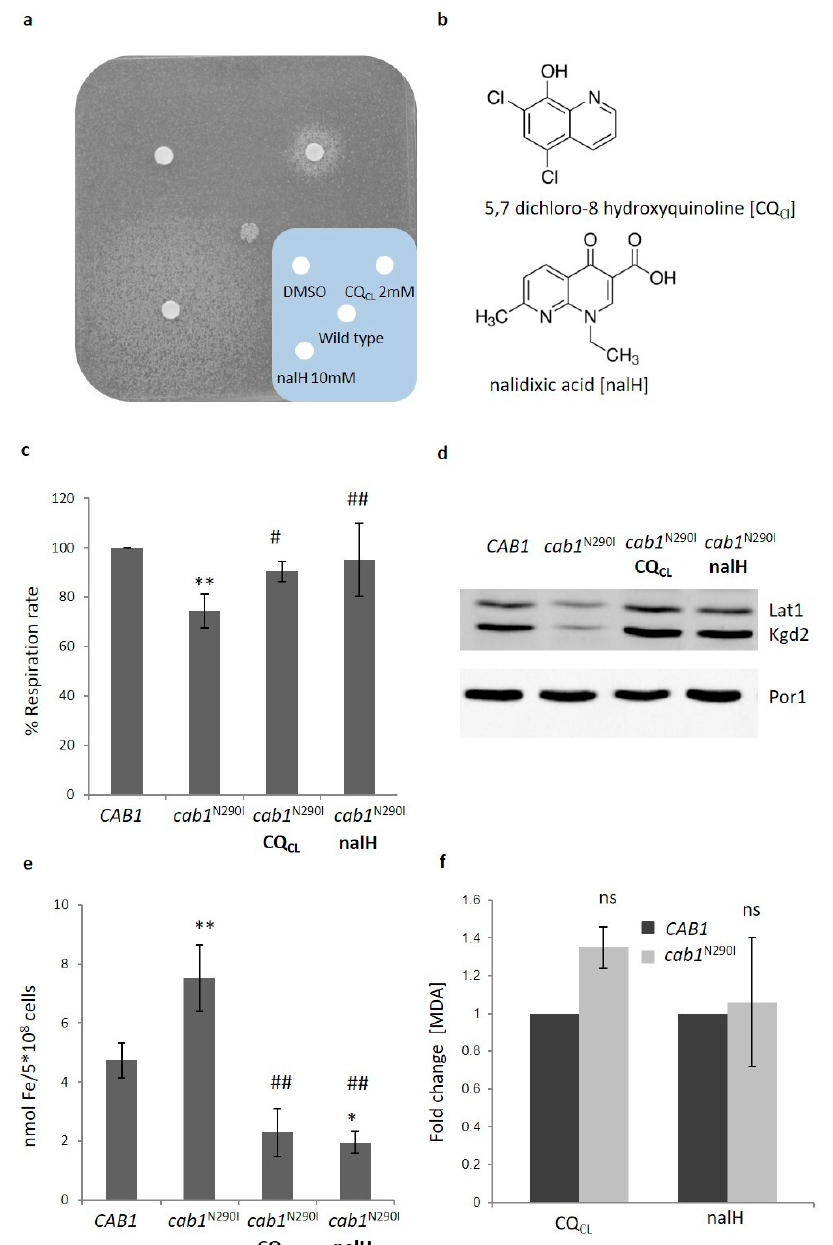
Figure 6. ( a ) 4 × 10 5 ( cab1 N290I ) cells were plated on YP medium supplemented with 2% ethanol. Three sterile filters were soaked with 2.5 µ l of each compound or DMSO. Plates were incubated at 28 ◦ C for 5 days. ( b ) Chemical structure of 5,7 dichloro-8 hydroxyquinoline (CQ CL ) and nalidixic acid (nalH). ( c ) Oxygen consumption rate was evaluated in wild-type and mutant strains grown with or without CQ CL /nalH. OCR was normalized to the strain transformed with the CAB1 wild-type allele. Values are means ± standard deviation. N = 3; n = 9 for each strain and condition. **: p < 0.01 relative to CAB1 wild-type strain and #: p < 0.05; ##: p < 0.01 relative to cab1 N290I mutant strain. ( d ) Representative image of western blot analysis of lipoylated subunits of PDH (Lat1p) and α -KGDH (Kgd2) extracted from strain harboring pFL39 CAB1 or pFL39 cab1 N290I grown with or without CQ C L/nalH. The filter was incubated with the specific antibody anti-Lipoic Acid and anti-Por1. N = 3; n = 3 for each strain and condition. ( e ) Cellular iron content was quantified in cells grown in the presence of CQ CL or nalH. Values are means ± standard deviation. N = 4; n = 12 for each strain and condition. *: p < 0.05; **: p < 0.01 relative to CAB1 wild-type strain and ##: p < 0.01 relative to cab1 N290I mutant strain. ( f ) MDA content was evaluated in wild-type and mutant strains grown with CQ CL /nalH. Values are means ± standard deviation. N = 1; n = 9 for each strain and condition. ns: not